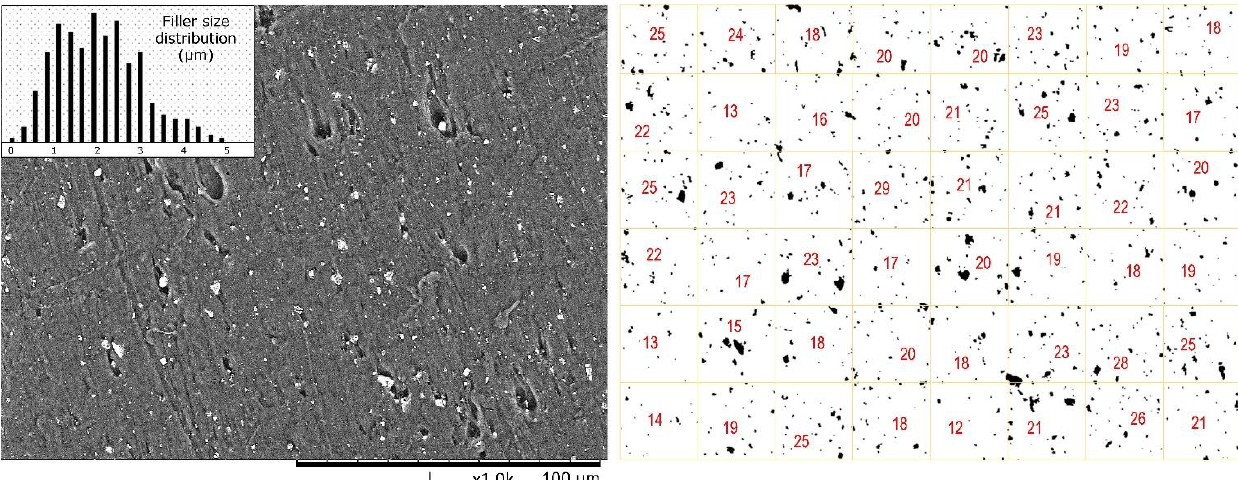
Figure 5. SEM image of fracture surface of F2nP10Q (obtained in liquid nitrogen) and its invert binary image with grid (a quantity of particles in each cell is depicted).